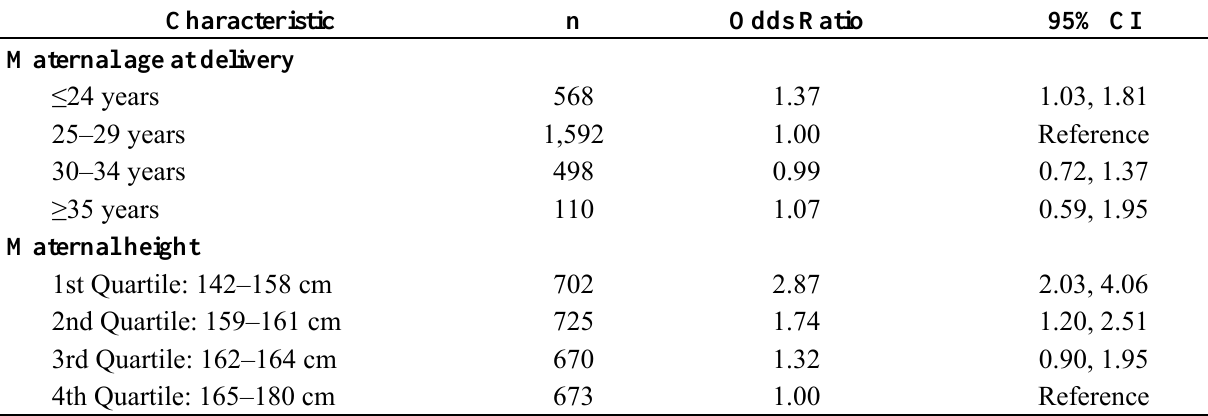
Table 4. Unadjusted odds ratios for associations between parental and perinatal factors and lower infant birth weight (<3,000